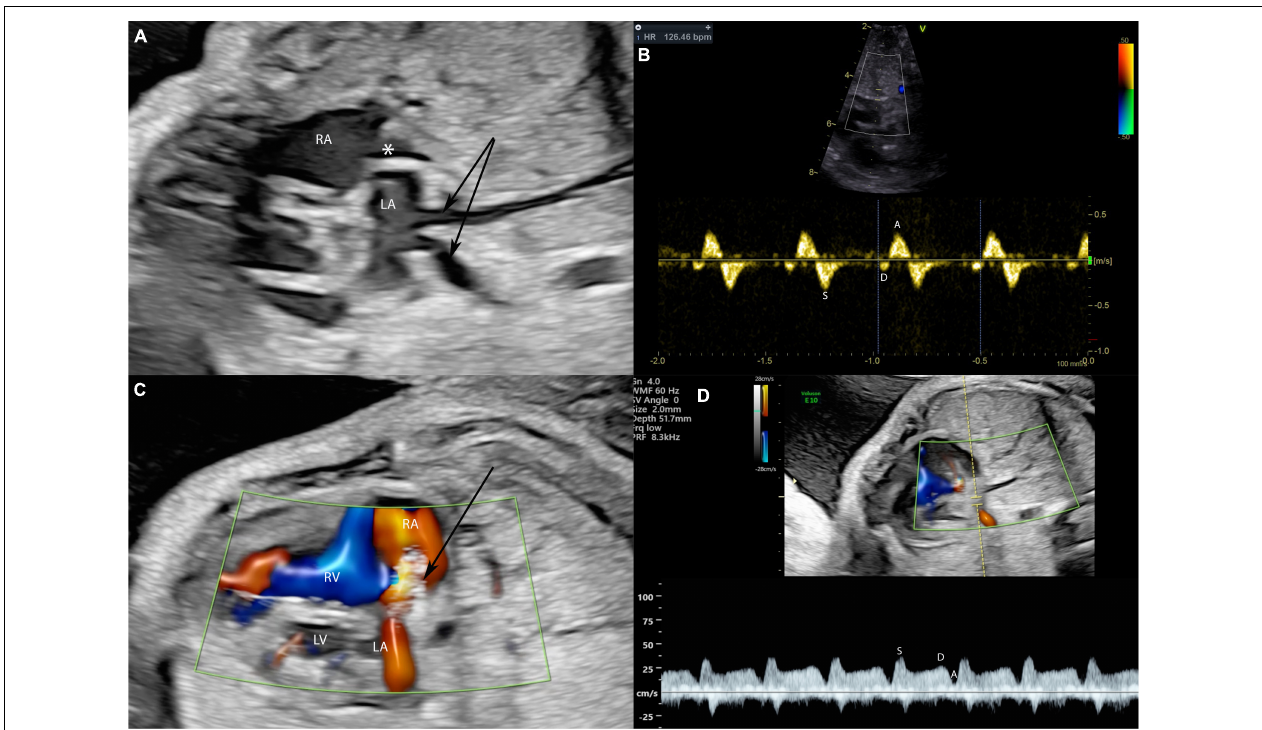
FIGURE 6 | A fetus at 28 weeks gestation with HLHS and intact atrial septum undergoing FCI. Stenting of the interatrial septum in a fetus with intact atrial septum and HLHS is shown. In panel (A) severely dilated pulmonary veins (arrows) indicate severe left atrial hypertension. The asterisk marks a thickened and into the right atrium bowing atrial septum. In panel (B) severe left atrial hypertension is indicated by severely abnormal pulmonary vein Doppler with almost missing diastolic flow and severe A-wave reversal during atrial systole. The arrow in panel (C) marks the placed atrial septum stent with good flow through the stent indicated by the red color Doppler signal. Note that the pulmonary vein Doppler in panel (D) is almost normalized in the same patient directly after stent placement with good diastolic flow and no presence of A-Wave